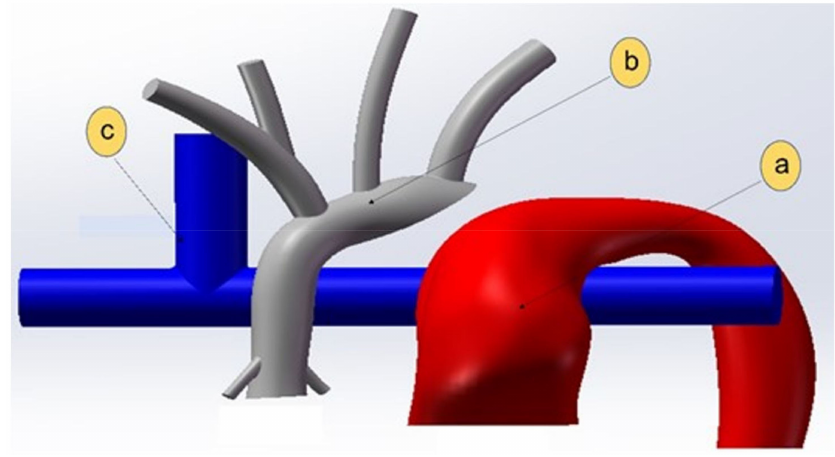
Figure 11. Fluid domain regions: ( a ) lower body circulation shown in red, ( b ) upper body circulation in grey, and ( c ) the pulmonary circulation shown in blue.